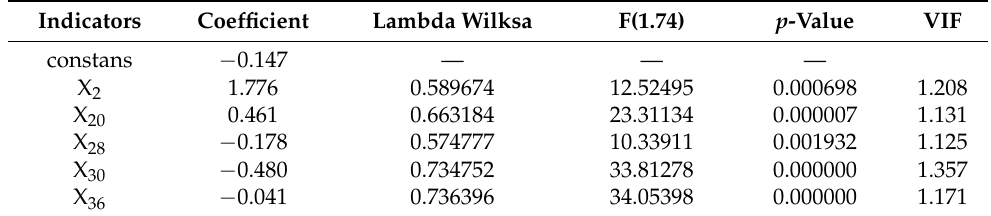
Table 3. Discriminant function for insolvency prediction of construction companies (ZAD).